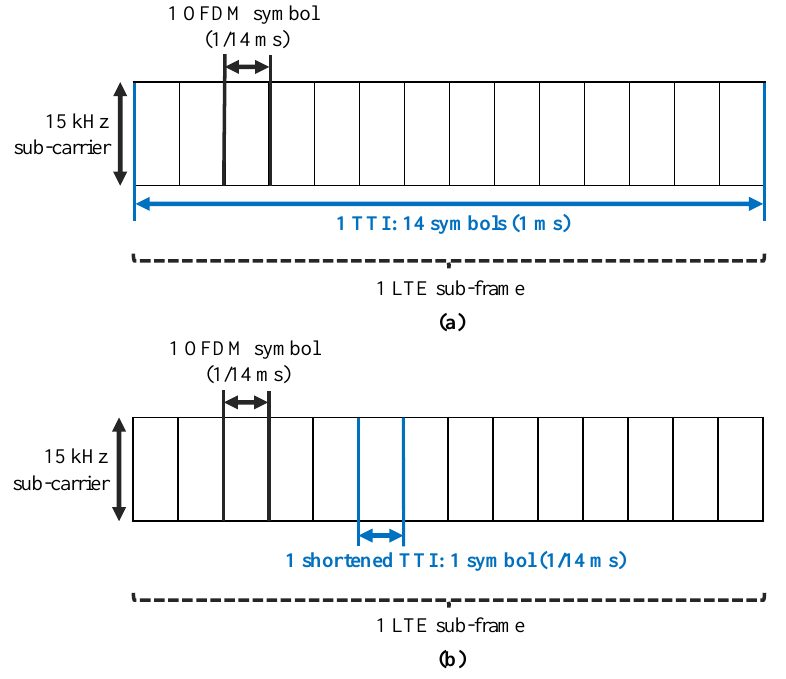
Figure 4. LTE sub-frame structure: ( a ) sub-frame with 1 ms TTI for conventional cellular systems, ( b ) sub-frame with shortened TTI (1/14 ms) for low latency